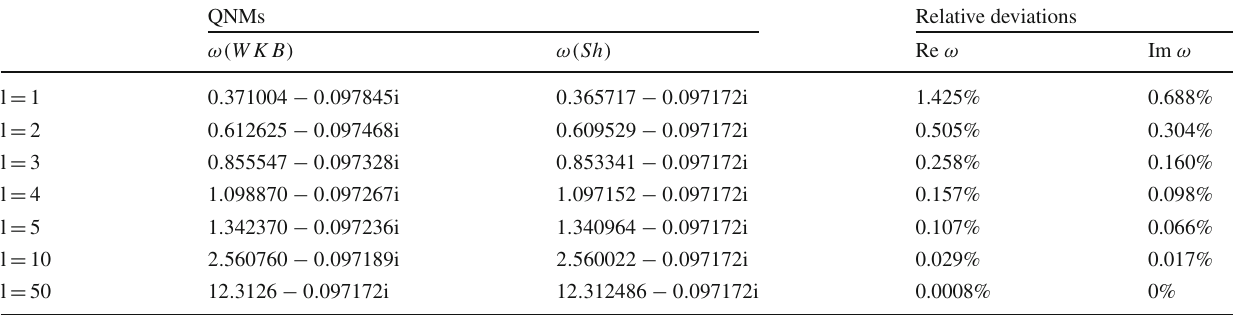
Table 13 The QNMs derived by the WKB approximation approach and shadow radius and the relative deviations. In the calculation, we let Q = 1 and α = − 0 .